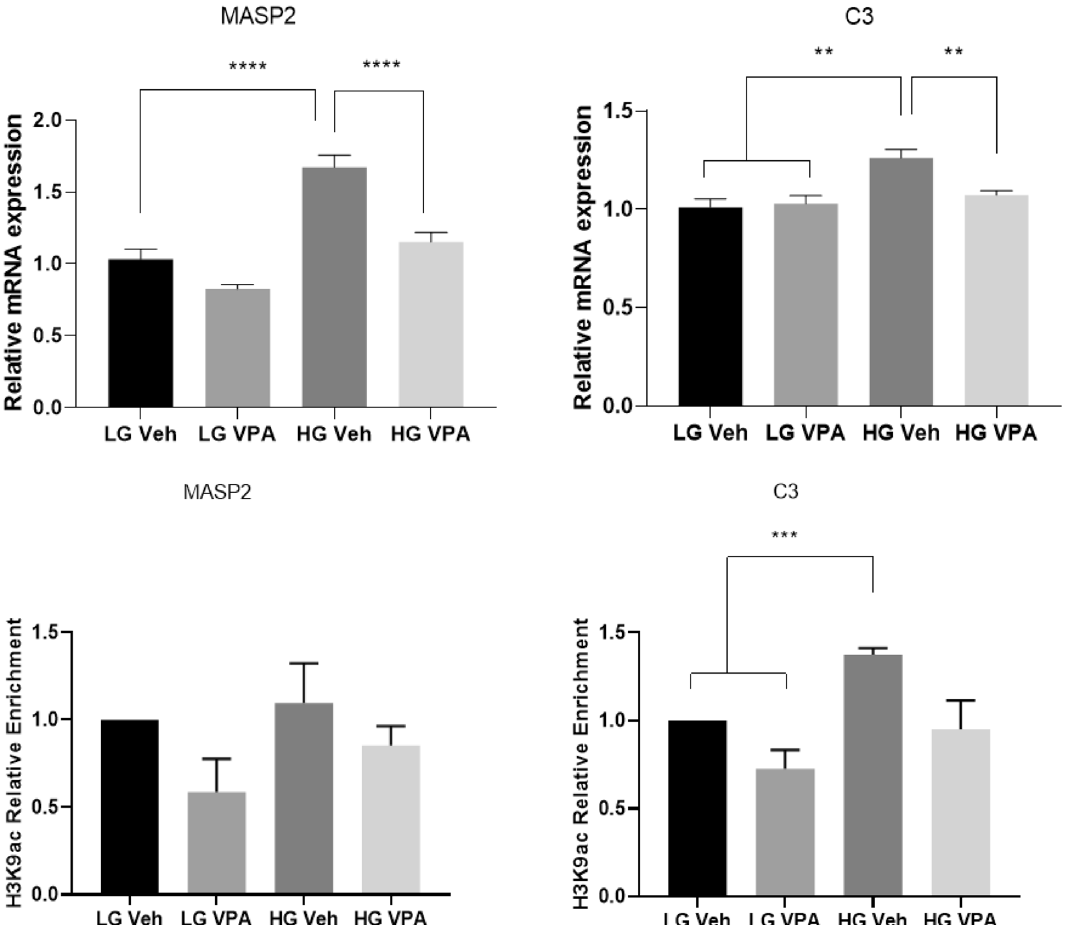
Figure 5. Validation of complement pathway gene ( MASP2 , C3 ) RNA expression and promoter H3K9ac enrichment. VPA stimulation attenuates the expression of these genes and is consistent with changes in promoter H3K9ac. LG, low glucose—normoglycemic condition. LGV, normoglycemic condition followed by VPA treatment. HG, high glucose—hyperglycaemic condition. HGV, hyperglycaemic condition followed